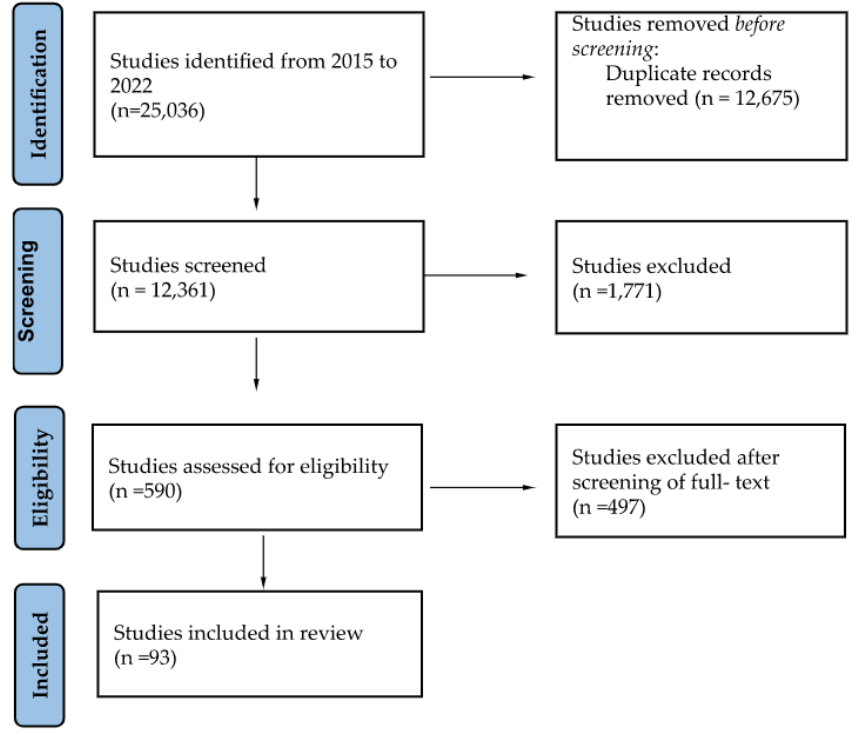
Figure 1. PRISMA flow diagram (based on Farrugia and Grima (2021)). Ninety-three articles that qualified for the review were subjected to thematic analysis. Thematic analysis is a method for analysing qualitative data that entails searching across a data set to identify, analyse, and report repeated patterns (Braun and Clarke 2006). Themes represent the core ideas and arguments that are used to formulate and explore research questions and concepts (Liñán and Fayolle 2015). The articles were grouped together based on their common themes. Each article’s relevance to one of the core topics was determined by reviewing both the abstract and the content. The qualitative analysis of the articles revealed 13 themes and subthemes in total. They include banking, technology, blockchain, customers and consumer decision-making, machine learning, lending, fraud and cybersecurity, financial inclusion, cryptocurrency, use of blockchain in cryptocurrencies, impacts of Fintech on banking and financial sector, country-specific Fintech impacts, and blockchain in banking. Broad themes such as “Banking”, “Blockchain”, and “Technology” are included alongside more specific sub-themes such as “Country-specific Fintech impacts” and “Blockchain and cryptocurrencies”. This allows us to distinguish between articles that examine general challenges and opportunities in various sectors associated with the adoption of new technologies and specific issues arising from technological disruption in the financial sector. The disparity in the specificity of identified themes reflects the heterogeneity of recent academic literature in terms of scope and research questions. Additionally, some of the themes are associated with relatively less research, which may help highlight possible research gaps. 4. Results In current studies, we used a systematic literature review to identify themes related to Fintech and banking, with a special focus on blockchain. Since 2015, 93 articles have been extracted and shortlisted for the final thematic analysis. The thematic analysis identifies four key themes and nine sub-teams that shed light on the various channels by